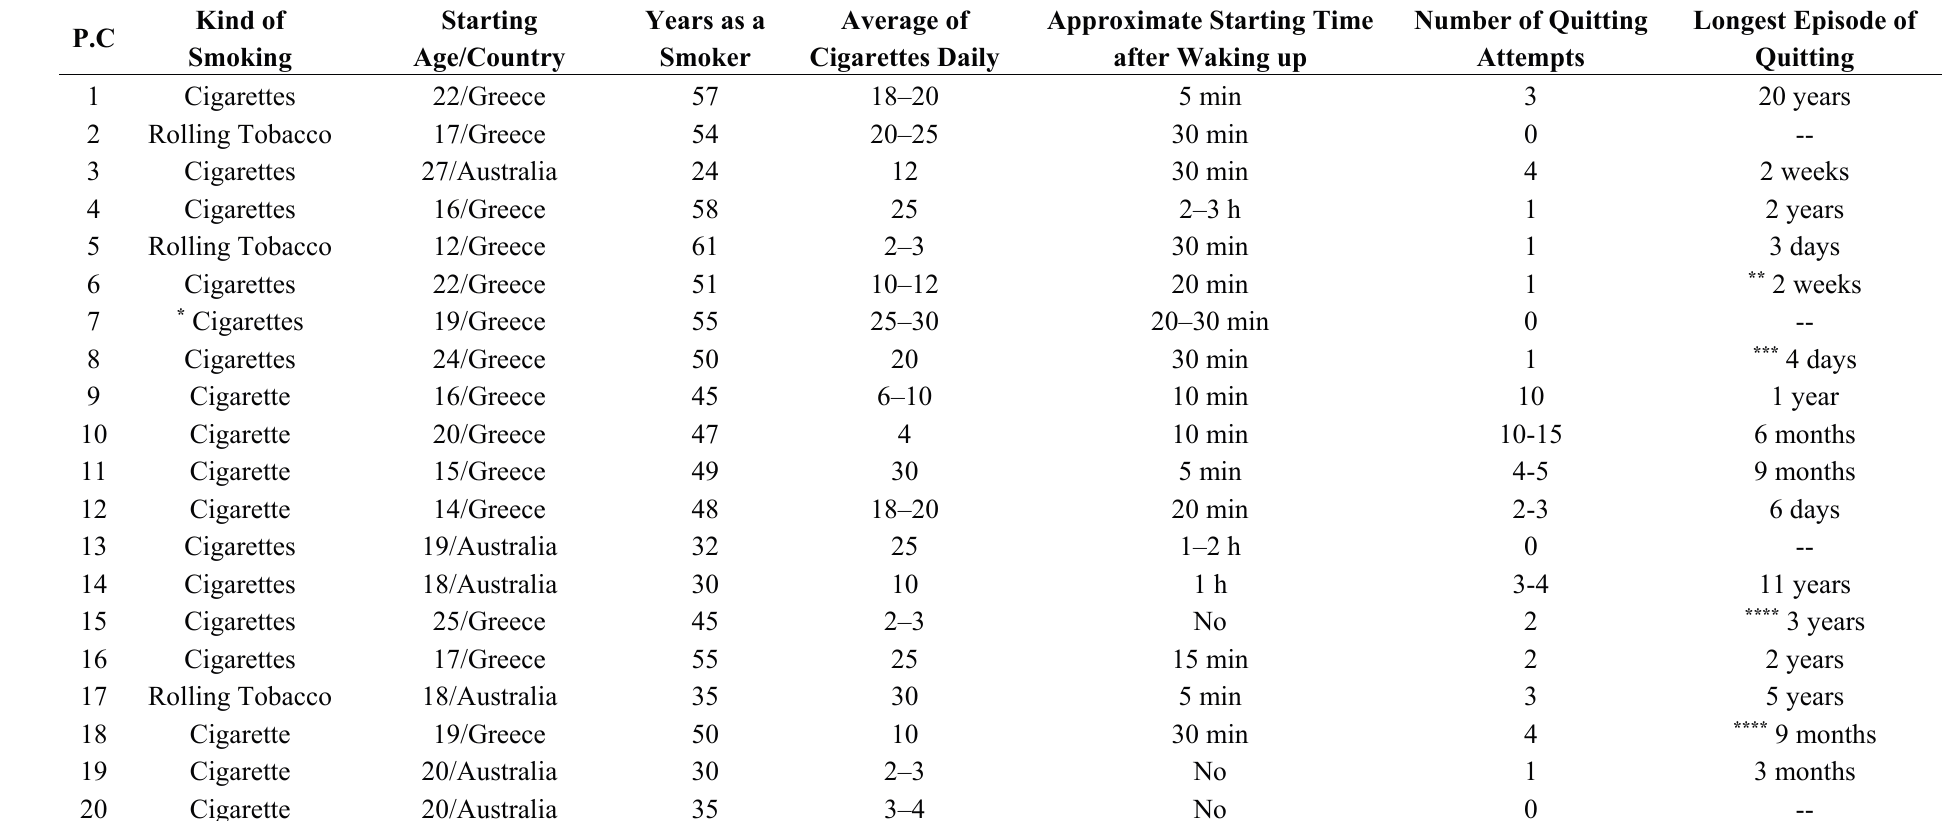
Table 2. Smoking-related characteristics of participants. Fix text flow-symbols after